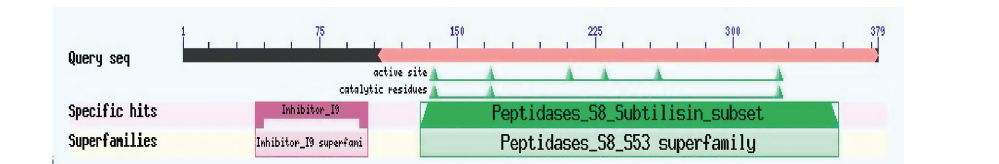
Figure 5: Characteristic fields of the Bacillus subtilis molecular sequence.